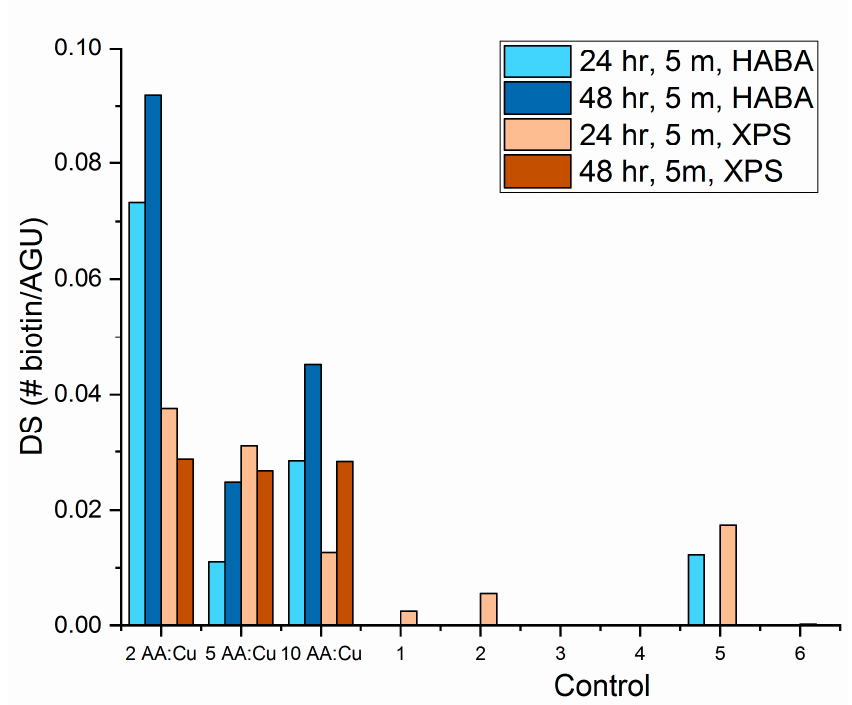
Figure 7. Degree of substitution of biotin on cellulose nanofibers after 5 months of storage calculated from HABA colorimetric assay and XPS survey scans.